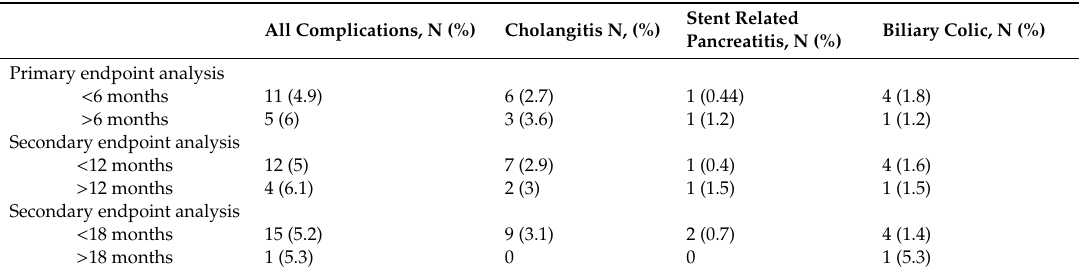
Table 2. Complications rate according to biliary stent duration.